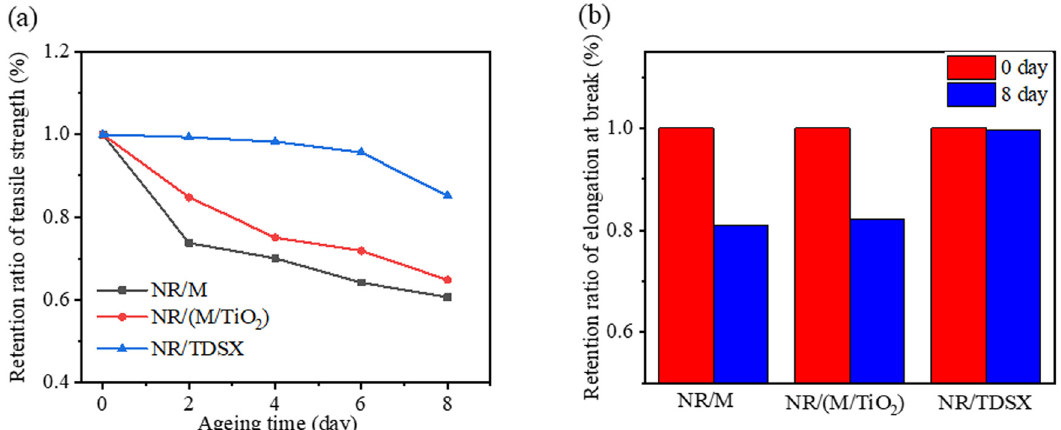
Figure 7: ( a ) The retention of tensile strength of di ff erent vulcanization systems and ( b ) the retention of elongation at break after 8 days of